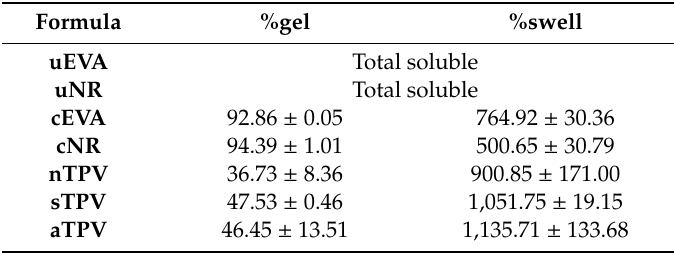
Table 1. Gel content (%gel) and swelling ratio of gel (%swell) of EVA / NR TPVs. uEVA: uncured EVA, uNR: uncured NR, cEVA: cured EVA, cNR: cured NR, nTPV: TPVs prepared by